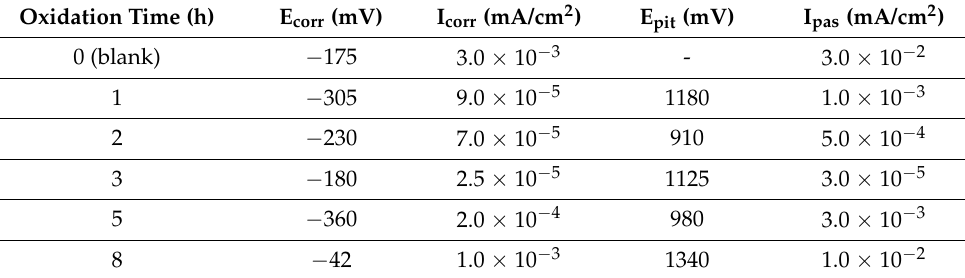
Table 1. Electrochemical parameters obtained from polarization